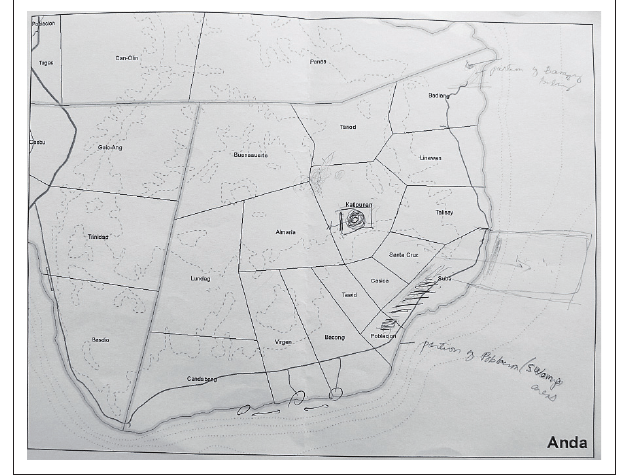
FIGURE 2: Example of a mental map picturing one informant’s interpretation of flood risks within the coastal barangay of